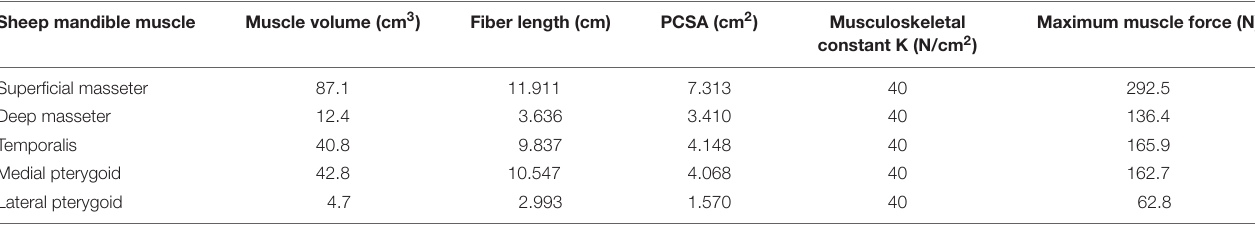
TABLE 1 | Sheep maximum muscle forces were obtained from the PCSAs, assuming the musculoskeletal constant K = 40 (N/cm 2 ) and the fiber activation A = 1.0 (Eq. 2) (Nelson, 1986). Sheep mandible muscle